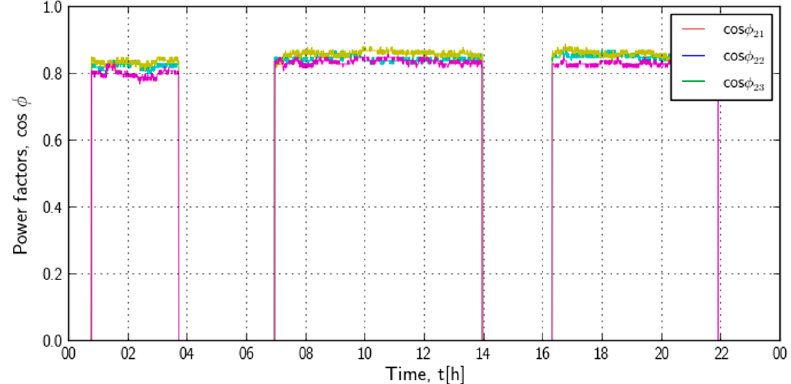
Figure 6. The diagrams of the PU2 power factor changes on 30 December 2009.